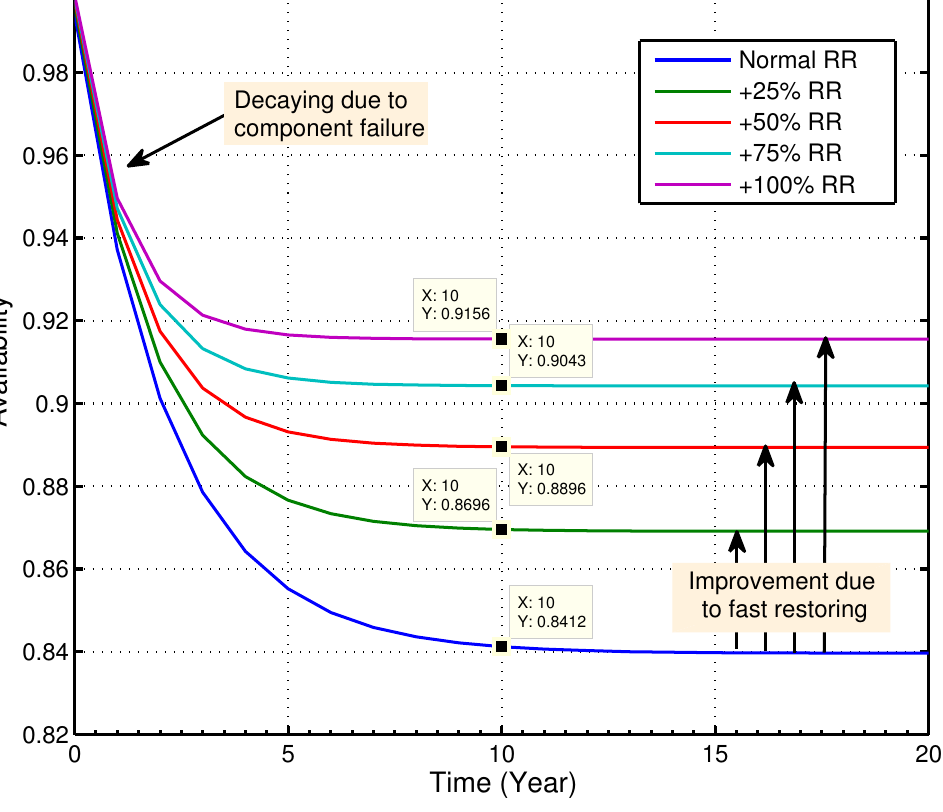
Figure 9. Vehicle’s availability at different restoration rates